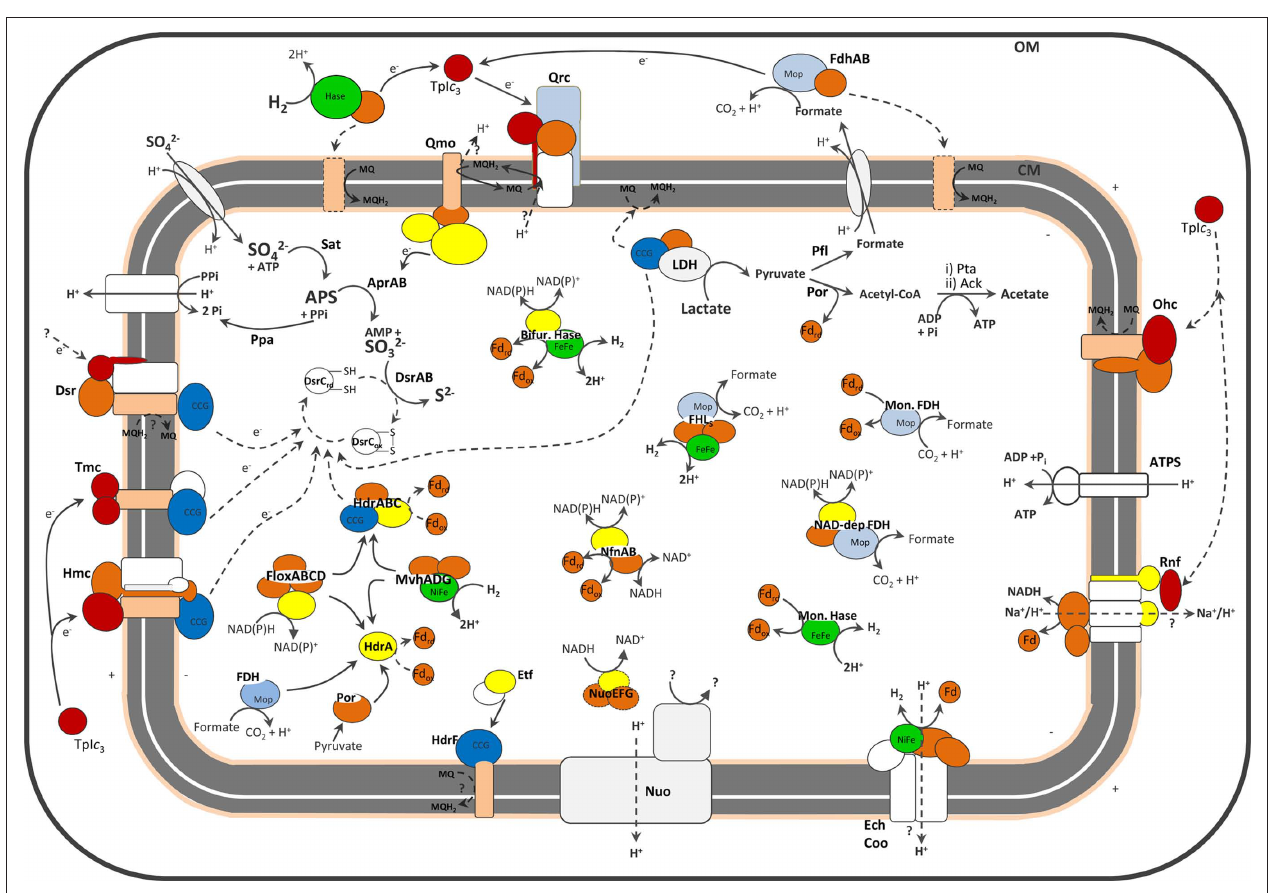
FiguRE 1 | Schematic representation of the cellular location of SRO main energy metabolism proteins. No single organism is represented. For the exact distribution of proteins in each organism please refer to the Tables. The dashed lines represent hypothetical pathways, or (in the case of periplasmic Hases and FDHs) pathways present in only a few organisms. For